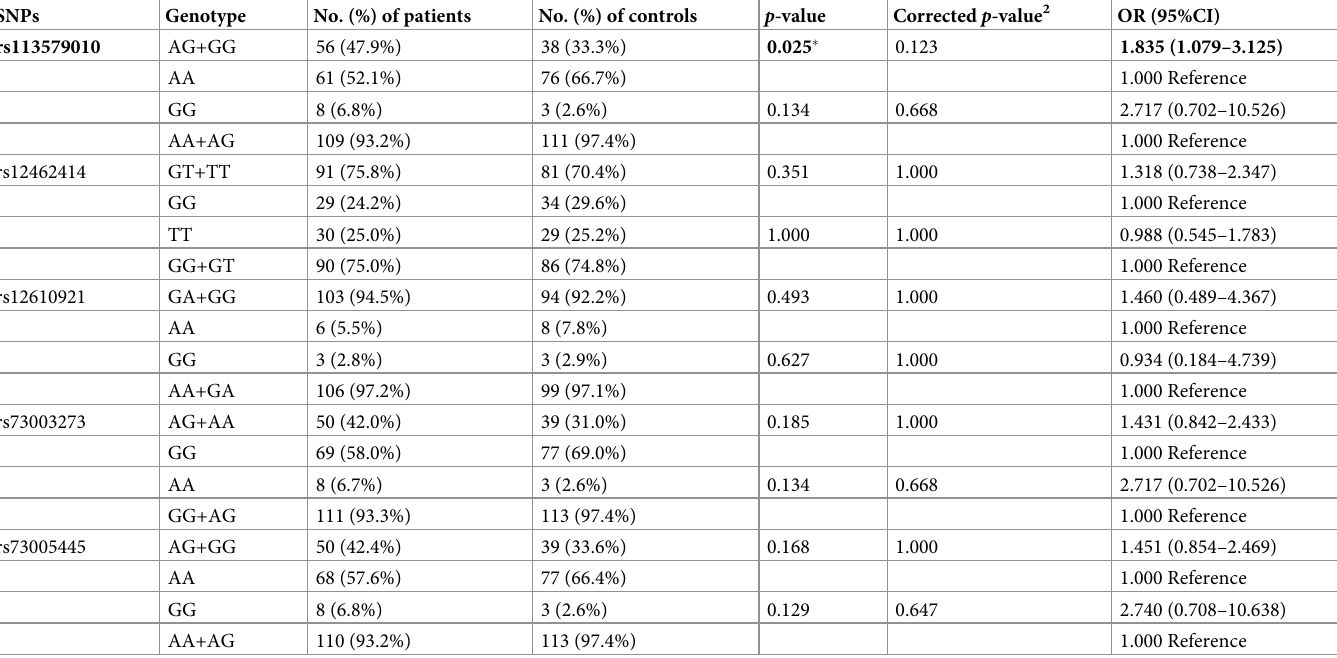
Table 2. Dominant and recessive effects of five functional SNPs in UCA1 between Taiwanese endometriosis patients and controls 1 . SNPs